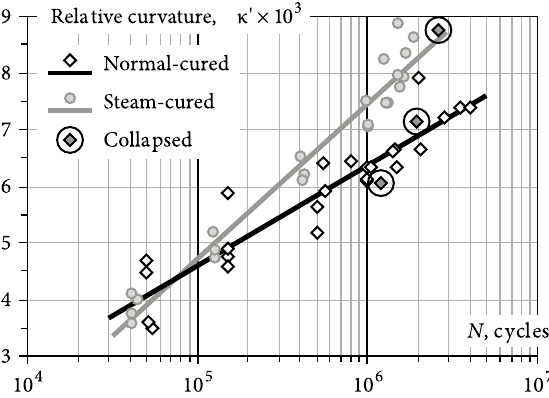
Fig. 7. Increment of curvature of the experimental beams due to cyclic loading and curing conditions